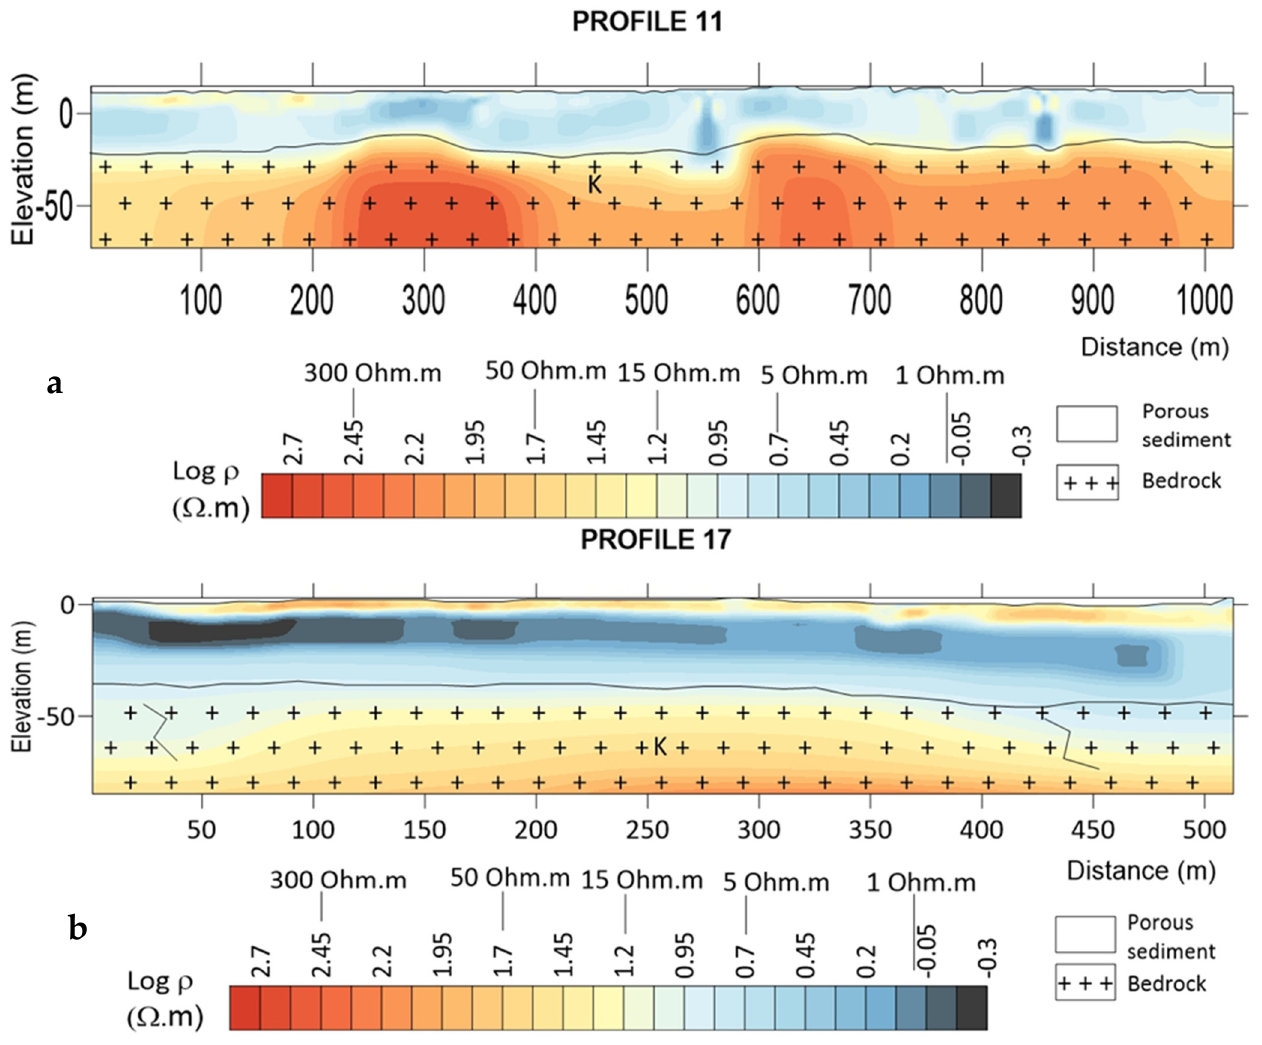
Figure 14. The presence of saline water at depth and strong lateral variations in salinity imaged by ERT (modified from Cong-Thi et al., 2021) [34].